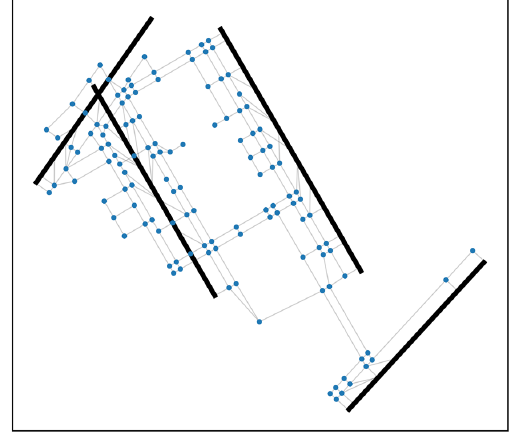
Figure 3. Graph model of Tokyo International Airport.